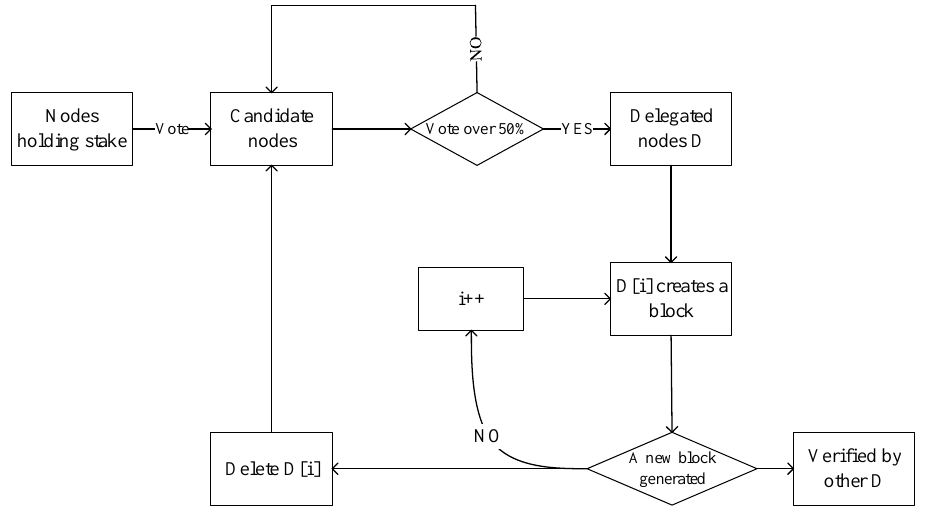
Figure 9. DPoS Algorithm